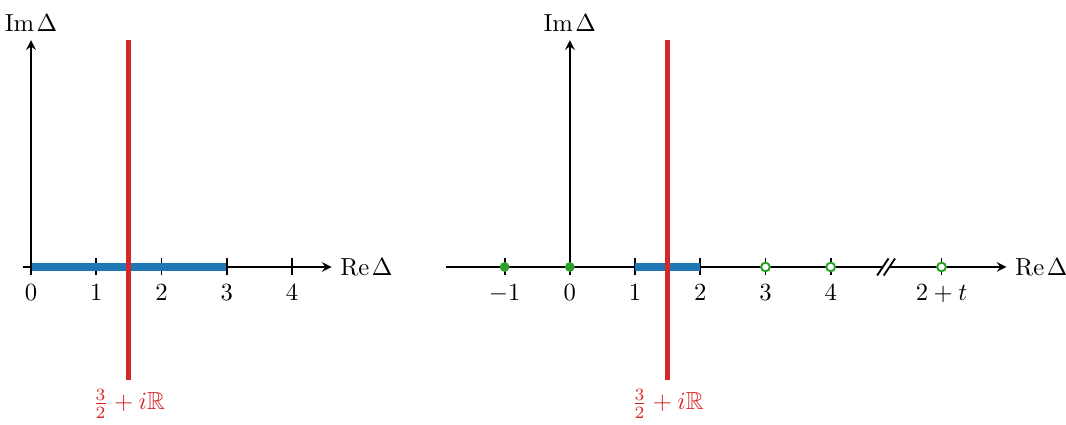
Figure 13: Illustration of scalar ( left ) and spin- (cid:96) ( right ) representations of SO ( 4,1 ) in the complex ∆ plane. The red lines corresponds to the principal series, while the blue lines mark the complementary series. The green circles for the spin- (cid:96) case denote the representations of the discrete series. Open circles are the shadows of the filled